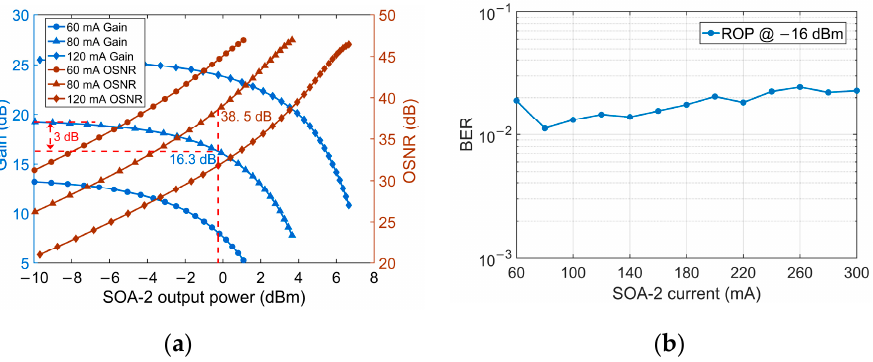
Figure 5. ( a ) SOA-2 gain and OSNR of 100 Gb/s PAM-4 signal versus output power; ( b ) BER of 50 Gbaud PAM-4 signal versus SOA-2 bias